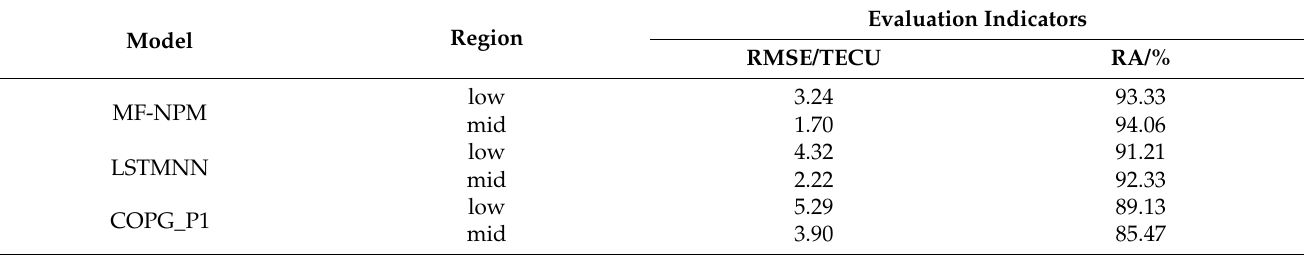
Table 4. RMSE and relative accuracy of the model outcomes (MF-NPM, LSTMNN, and COPG_P1) from IGS GIMs in different latitude regions during the peak year of solar activity